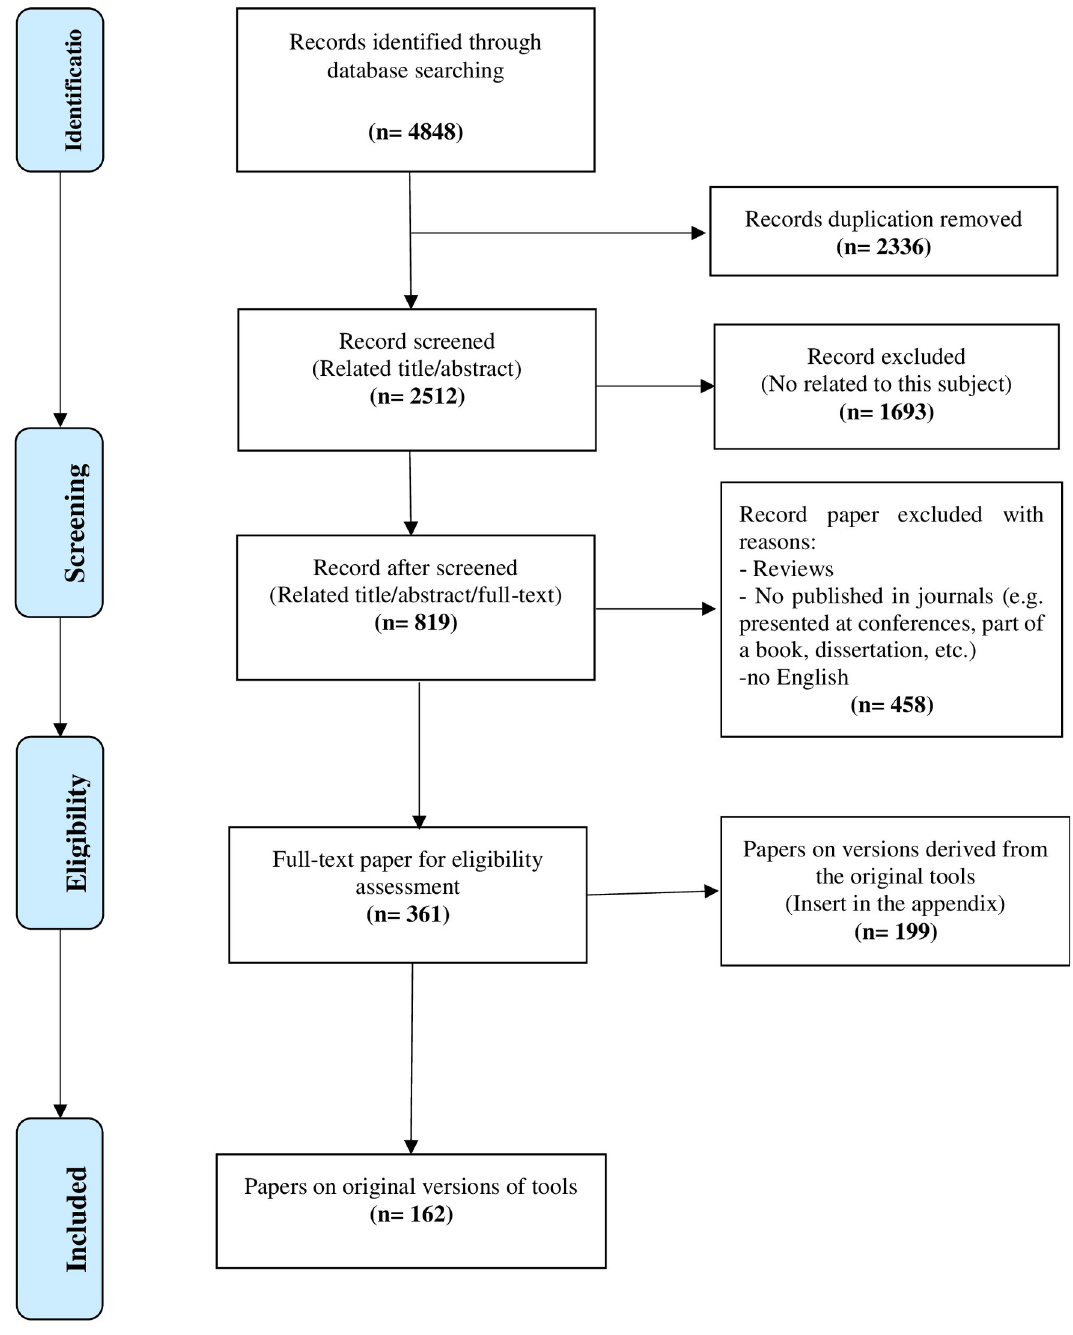
Fig 1. Flow diagram of the study selection